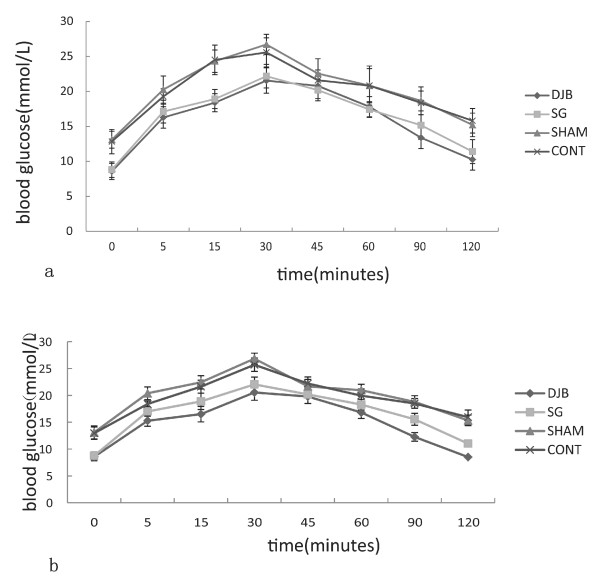
a. OGTT was performed 4 weeks after operation. b.Another OGTT was taken 8 weeks after operation. It showed an improvement of glucose tolerance in both SG and DJB groups compared with the SHAM rats at 4 weeks as well as 8 weeks after operation (P <0.001). SG group showed a better glucose tolerance than DJB group (P <0.001).